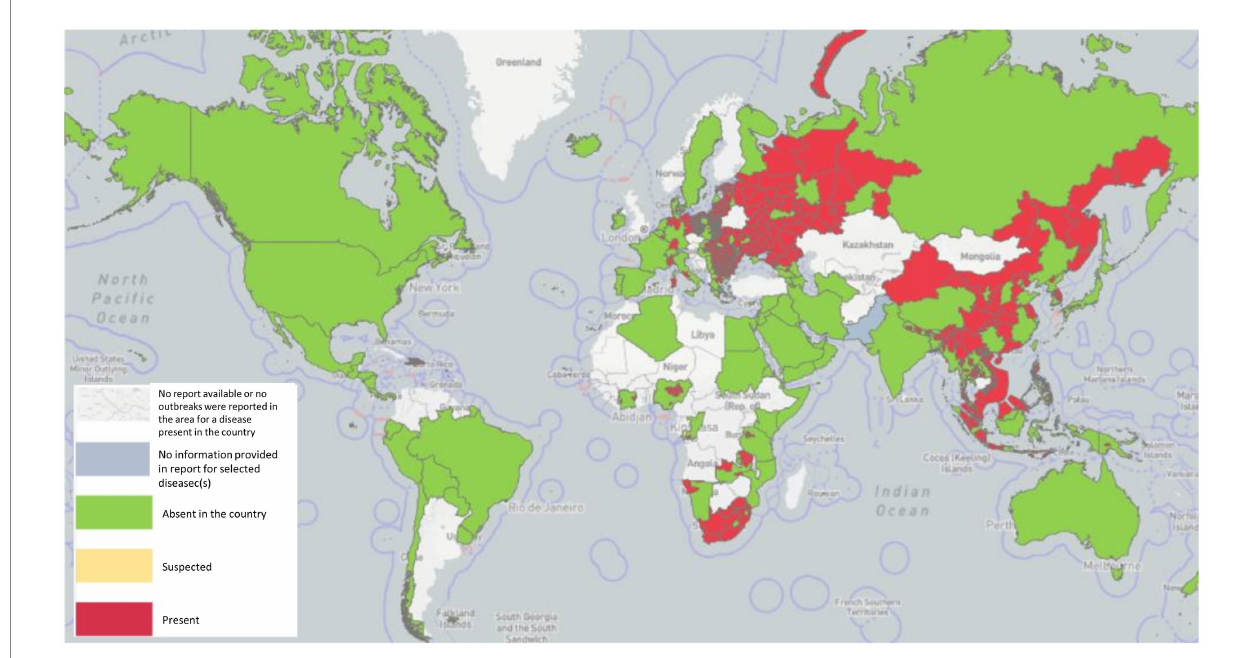
FIGURE 1 ASF has been reported in 45 countries globally since 2020 as of 29 September 2022 (Source: World Organization for Animal Health, World Health Organization, October 2022 line visit).